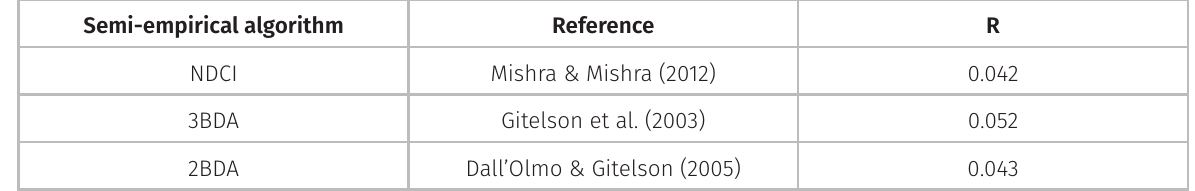
Table IV. Pearson’s correlation coefficient (R) between semi-empirical algorithms and Chl- a in situ data. Semi-empirical